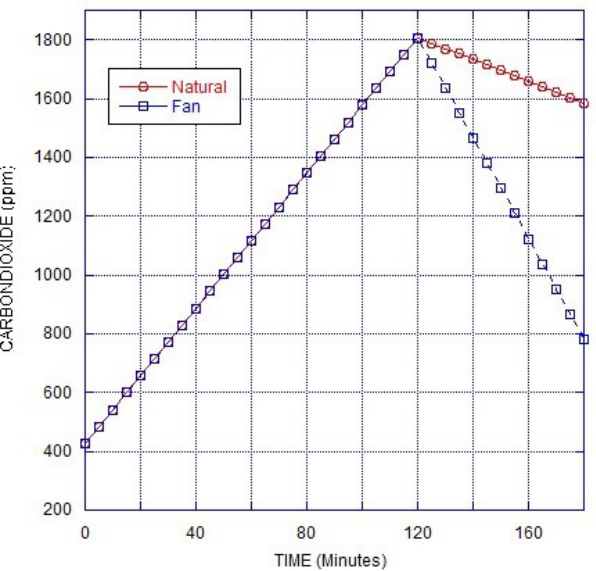
Figure 6. Effects of CO 2 removal by natural means and using ventilation fan after students have left a classroom